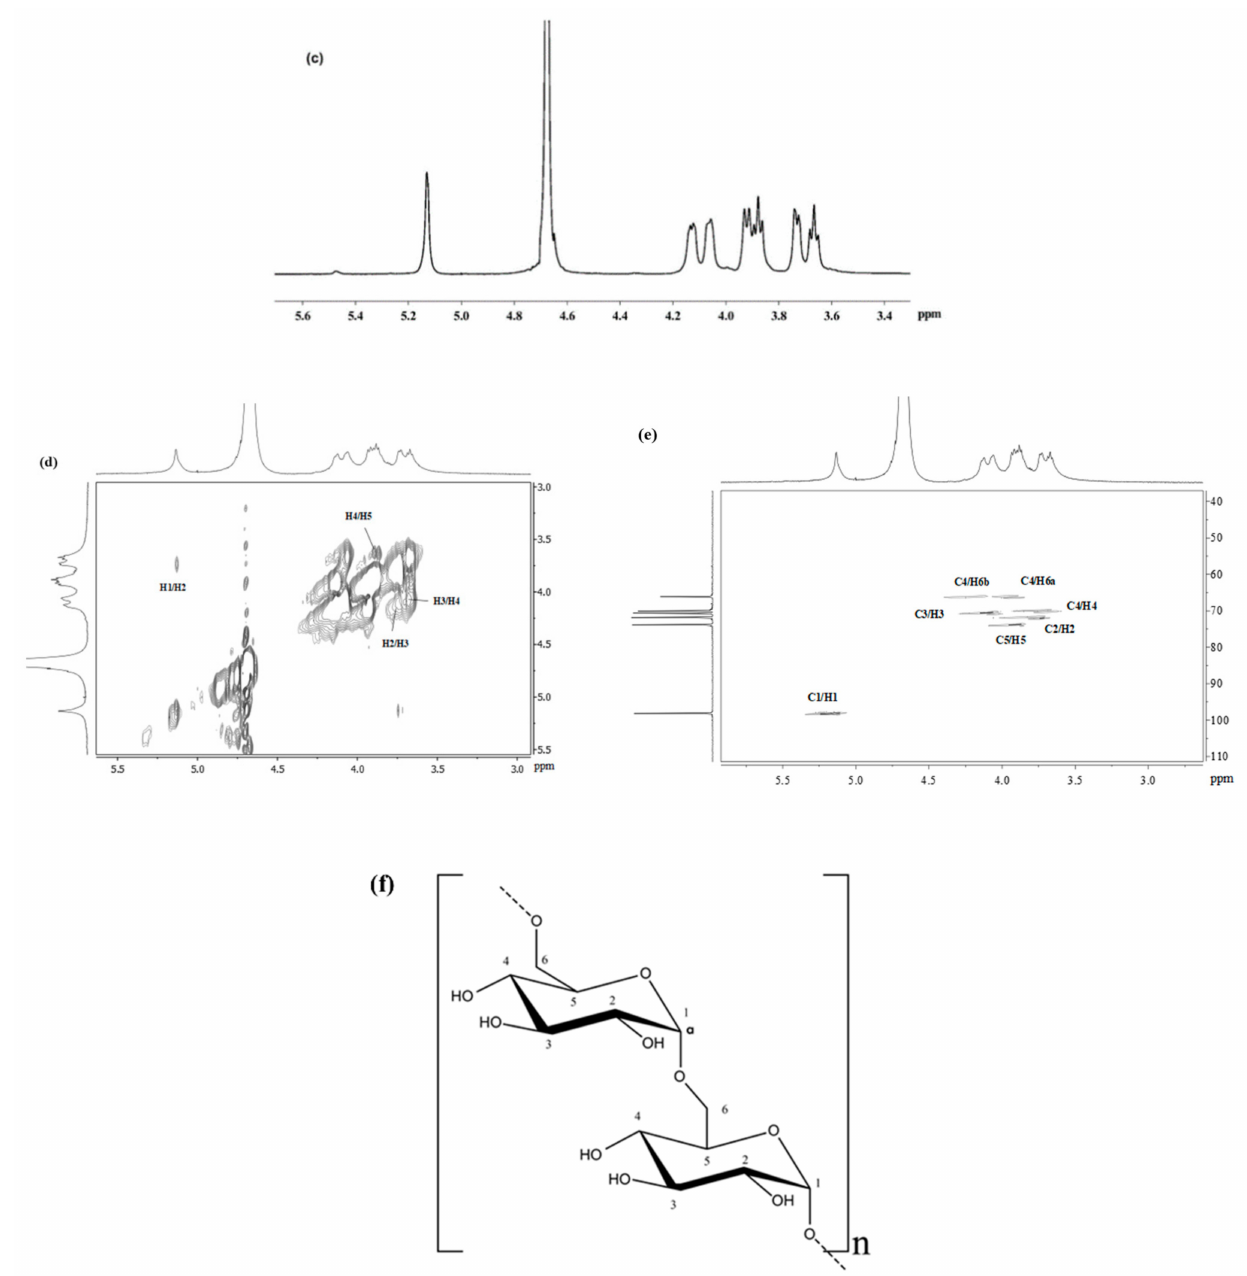
Figure 5. GC–MS spectra ( a ), 13 C-NMR spectra ( b ), 1 H-NMR spectra ( c ), COSY-NMR spectra ( d ), HMQC-NMR spectra ( e ), and the main backbone of MPF2 ( f ) from A. hemibapha subspecies javanica